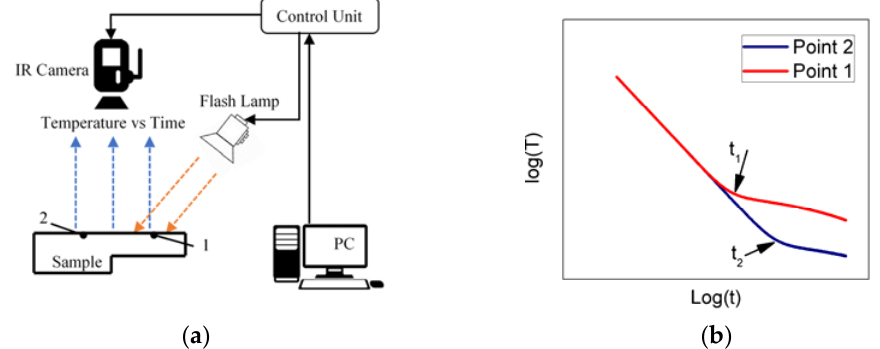
Figure 1. ( a ) Pulsed thermography experimental setup; 1 denotes a position on the sample surface with a reduced thickness and 2 denotes the through ‐ thickness of the sample. ( b ) Typical observed time ‐ temperature decay curves in the logarithmic domain for points 1 and 2, respectively, where the time of heat saturation 𝑡 (cid:2869) and 𝑡 (cid:2870) are the keys to measure the thickness of the material.